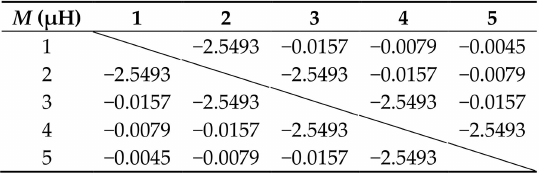
Table 2. The mutual inductances between different transmitting